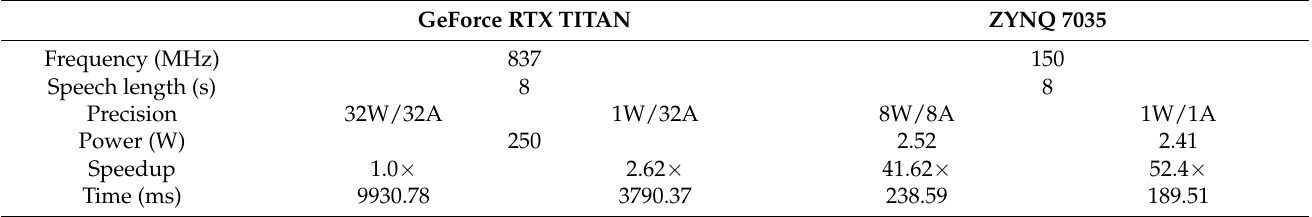
Table 6. Comparison with GPU.